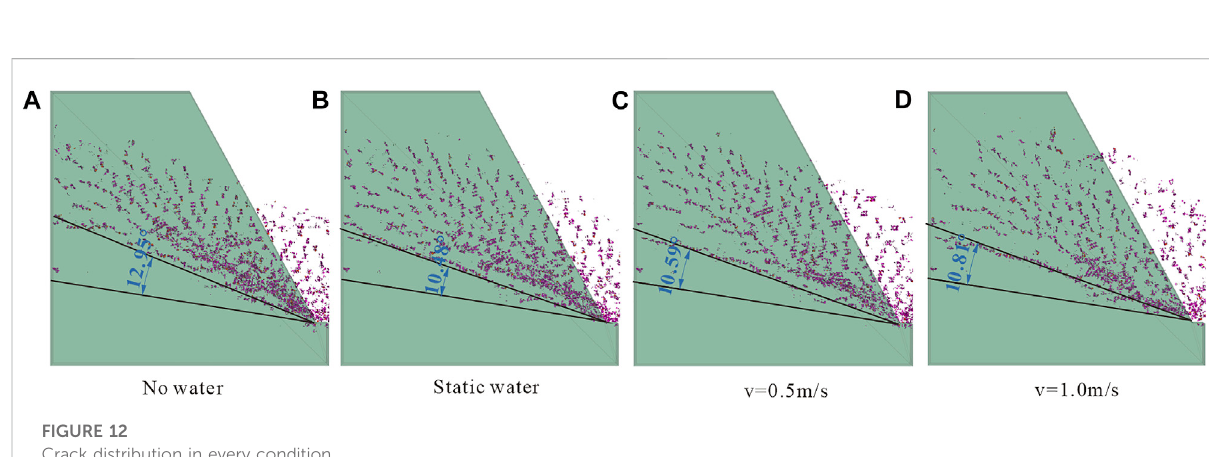
FIGURE 12 Crack distribution in every